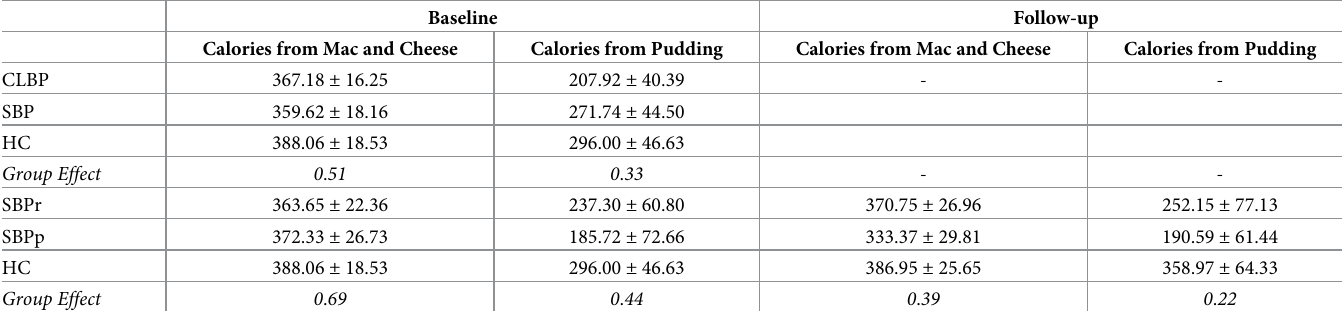
Table 4. Caloric consumption during session 2.